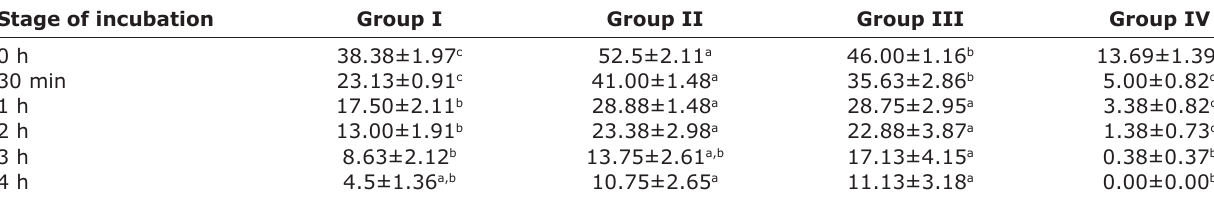
Table-3: Effect of post-thaw incubation at 37°C on progressive motility (per cent, mean±SEM) of Malabari buck spermatozoa frozen in extenders with varying level of cholesterol (n=8). Stage of